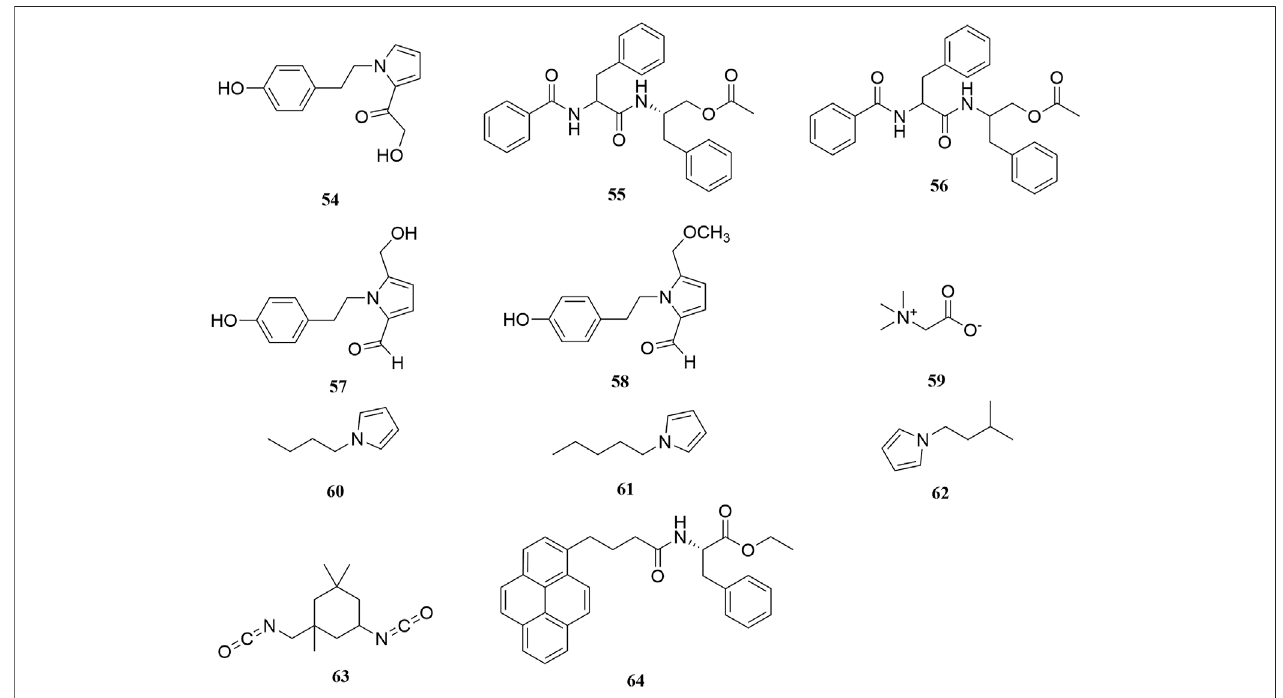
FIGURE 4 | Chemical structures of alkaloids ( 54 – 64